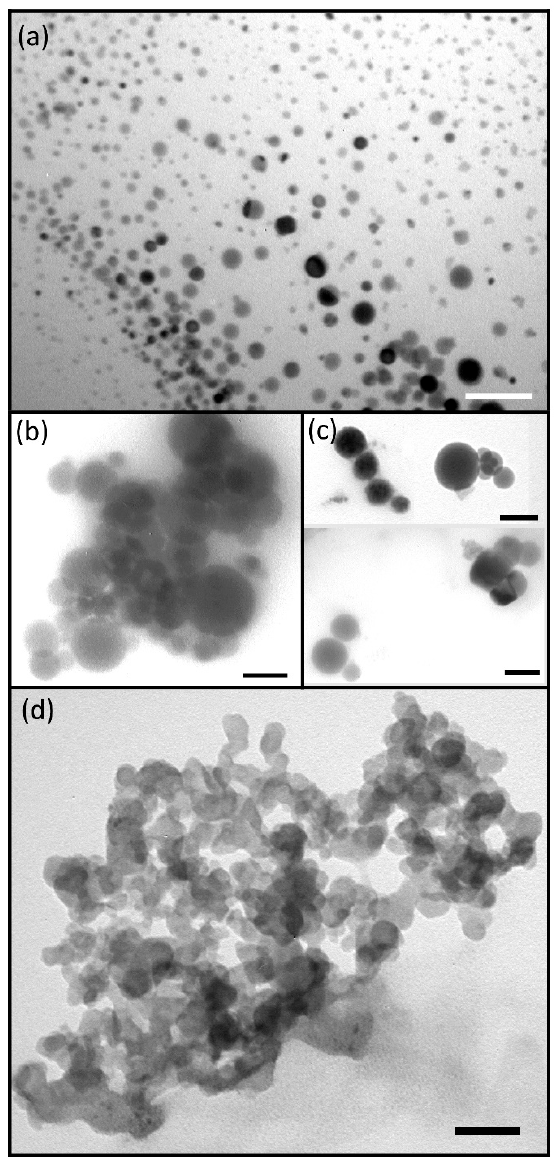
Figure 5. Transmission electron microscopy (TEM) images of the polymer–double strand 20-mer DNA. ( a ) ZS-371-1; ( b ) ZS-371-2; ( c ) ZS-371-3; and ( d ) ZS-371-5 polymers. Initial polymer concentration was 4 mg/mL, siRNA–10 µM with a polymer to DNA ratio of 4:1 (volume to volume) which corresponds to the conditions of in vitro experiments. Scale bar represents 100 nm.